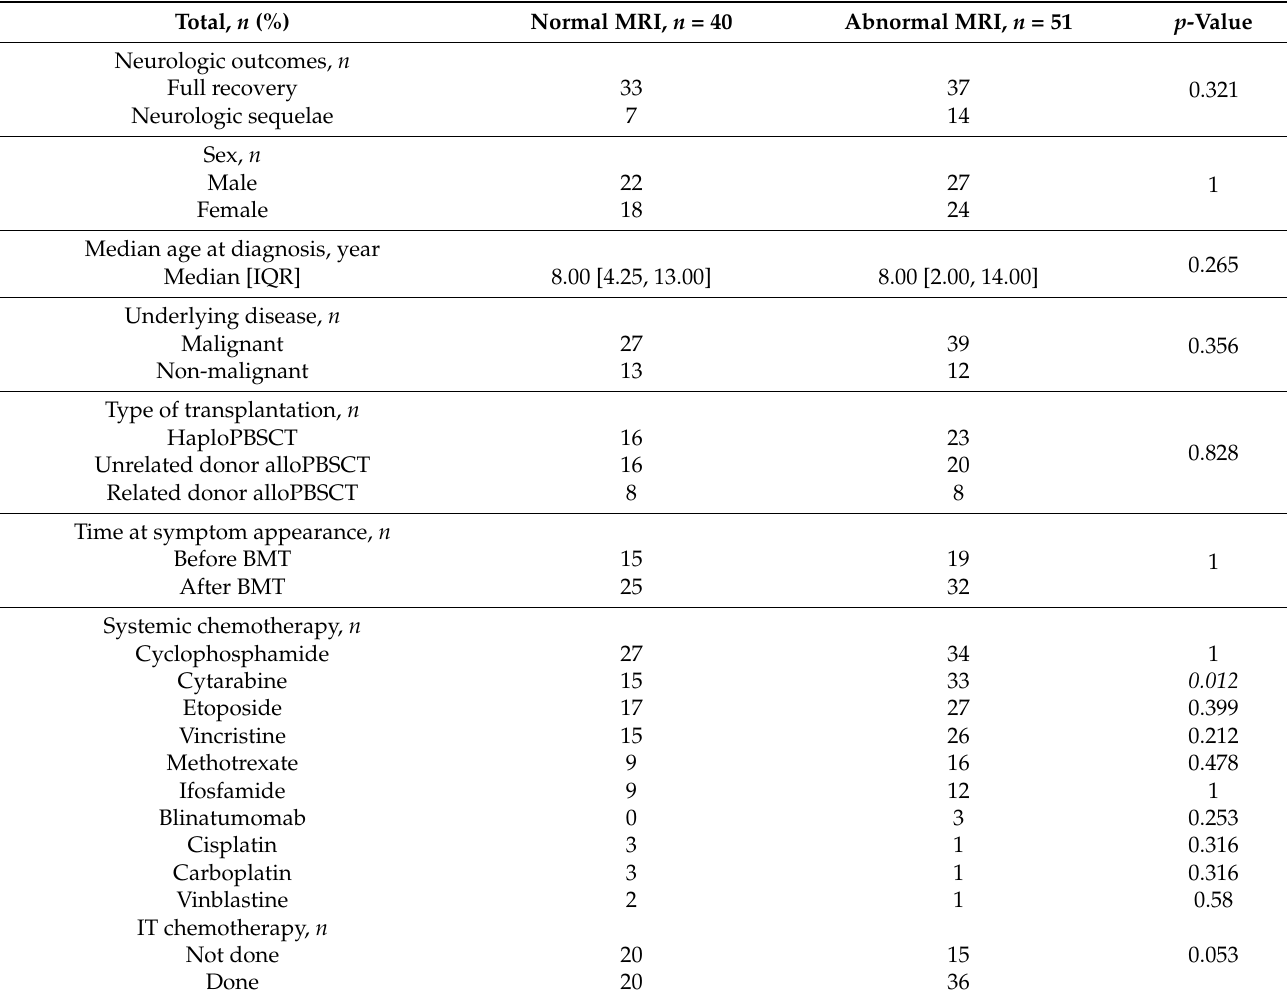
Table A1. Neurological Outcome Assessments According to MRI